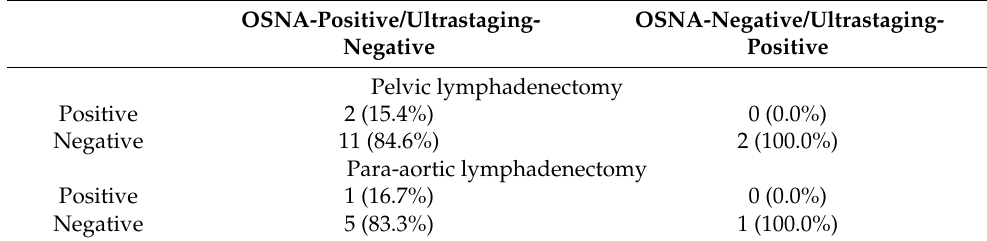
Lymphadenectomy results according to ultrastaging and OSNA: summary of discordant